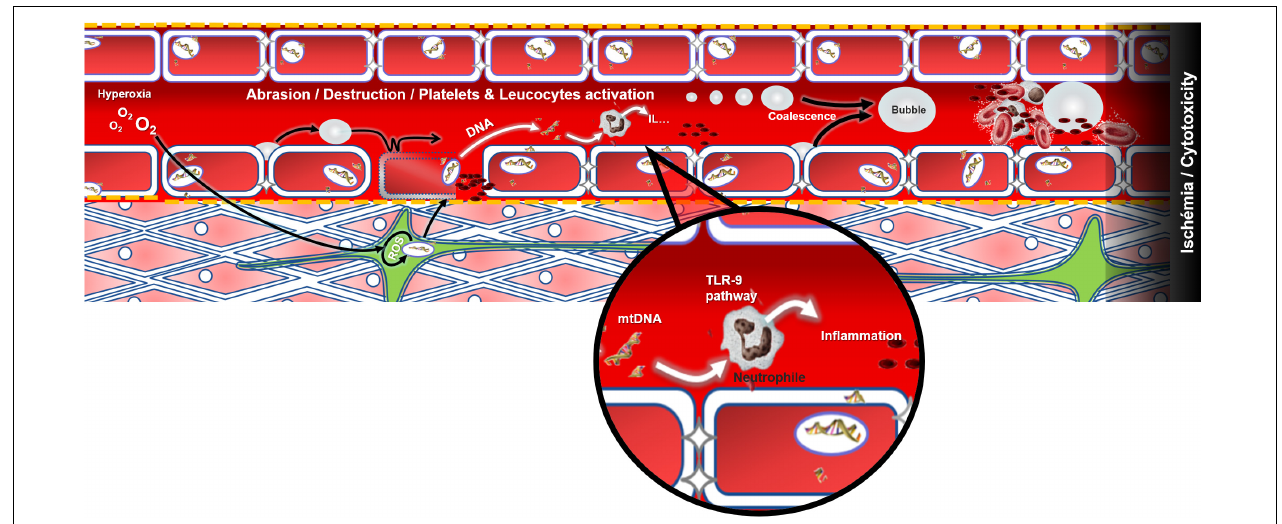
FIGURE 4 | Modeling of decompression sickness incorporating the genesis and increase of bubbles at the vascular level. Excess oxygen could be the source of oxidative stress which alters mitochondrial function and weakens the vascular (red), neuronal (green) or muscular (pink) tissues for example. Following decompression, the bubbles may either abrade the endothelium and leave the collagen bare (yellow dots) which will activate the platelets (in black), or activate the platelets and the immune system directly when they make contact, or even cause an obstruction to the circulation. A dark area is established in the end downstream of the thrombosis: this last illustrating the sum of effects, like cytotoxicity and ischemia among athers, that may spread in the body and contribute to the vicious circle of DCS which is poorly understood. The release of mtDNA would be concomitant and would also participate in the activation of the immune